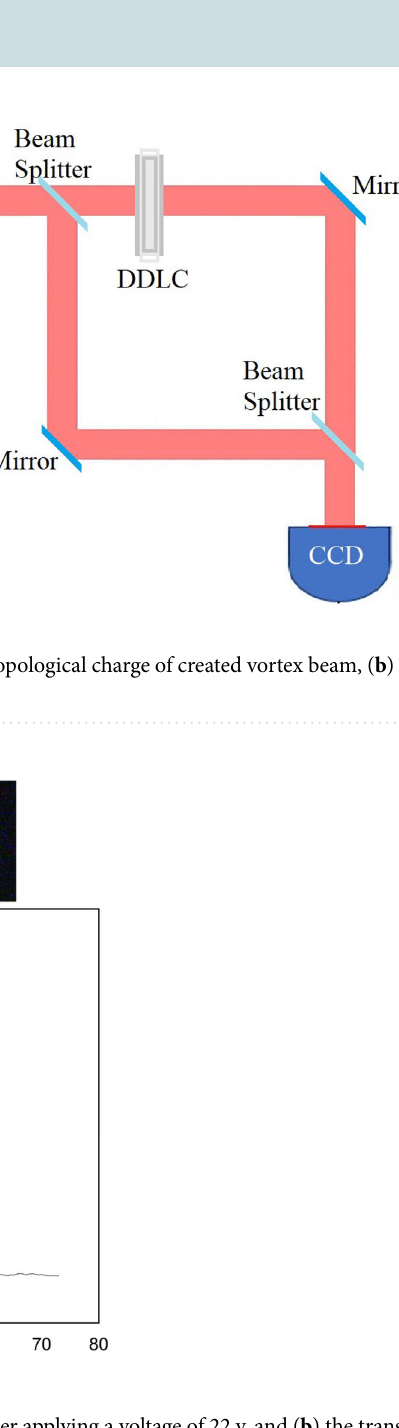
Figure 12. ( a ) The beam passed through the sample after applying a voltage of 22 v, and ( b ) the transmitted beam